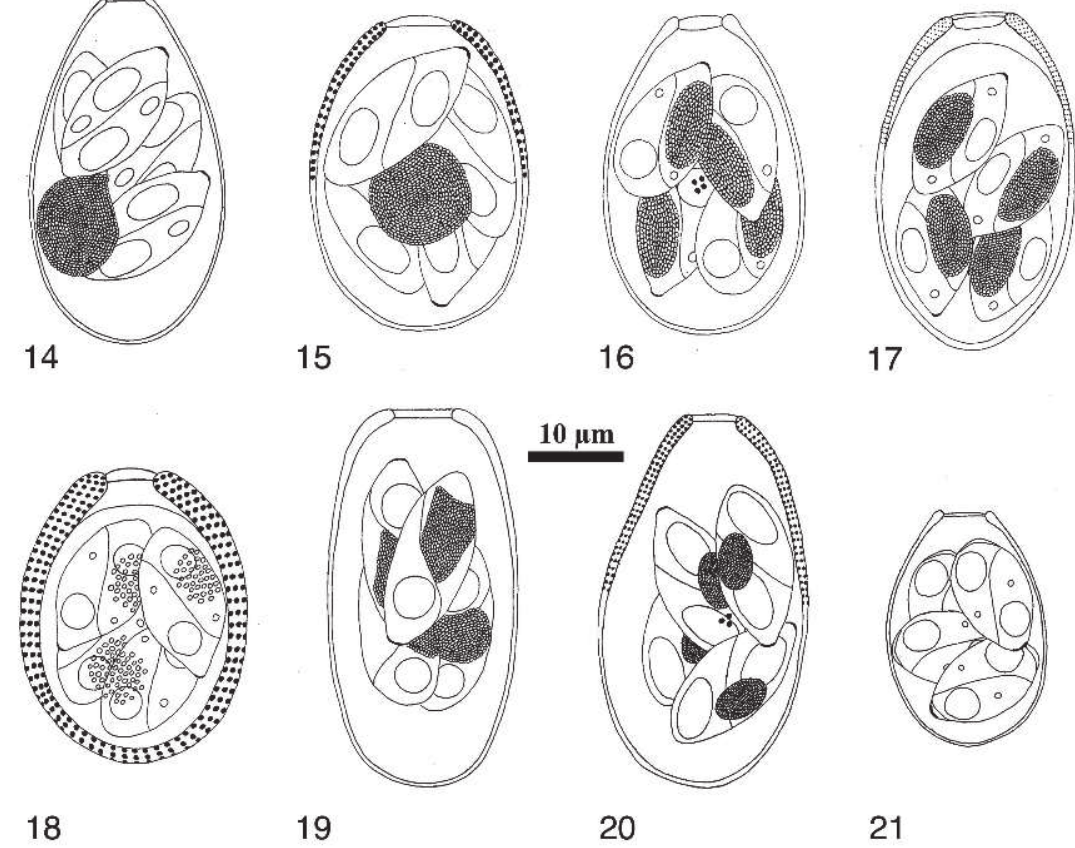
Fig. 4. – 14. E. reniai ; 15. E. pierrecouderti ; 16. E. cabareti ; 17. E. stiedai ; 18. E. lapierrei ; 19. E. macrosculpta ; 20. E. tailliezi ; 21. E. baba- tica ( ×